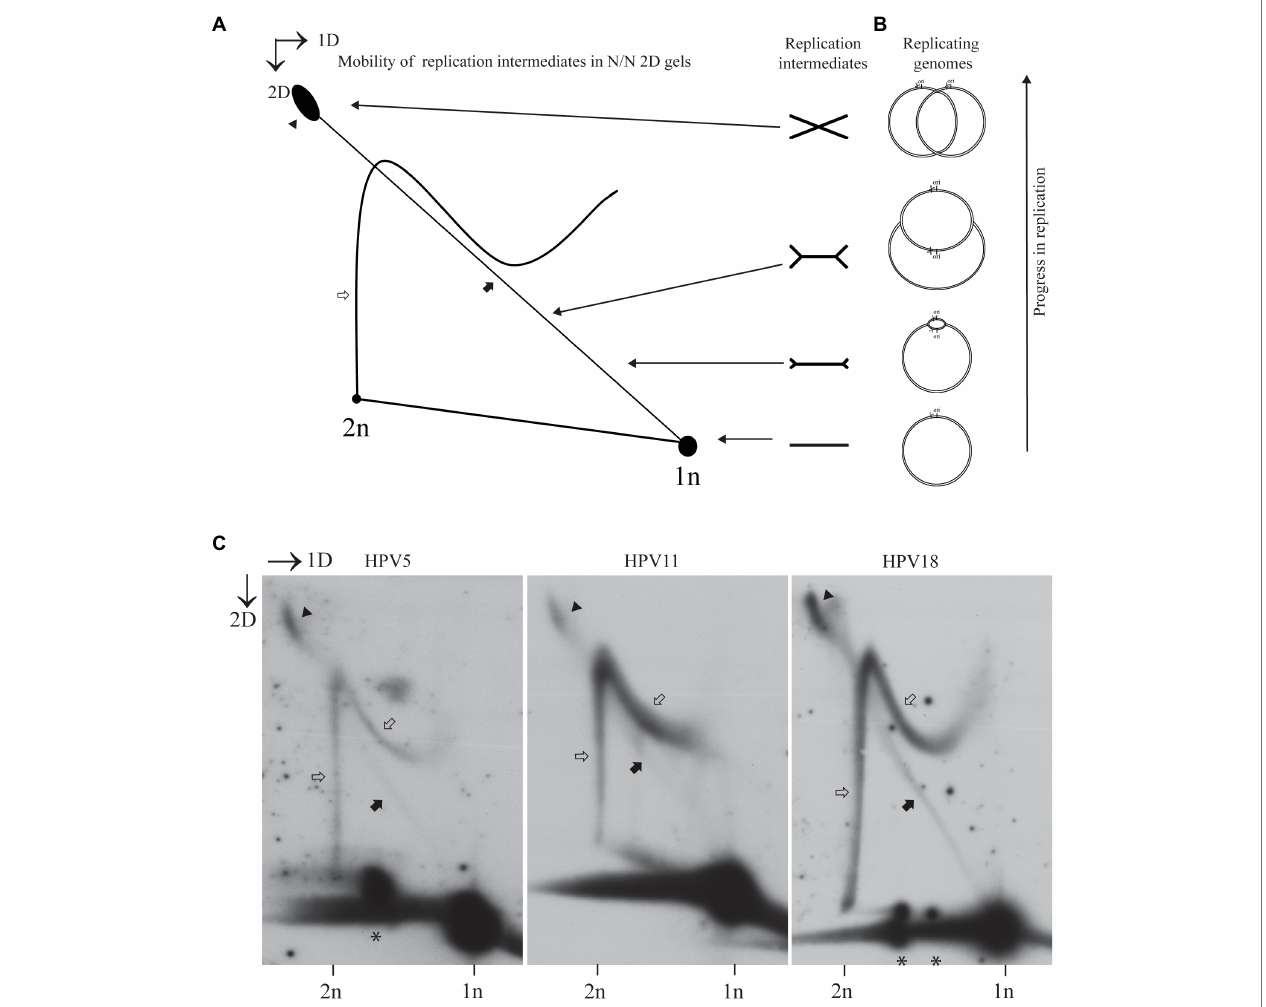
FIGURE 1 | Usage of the non-theta replication mechanism during transient replication is characteristic to different human papillomavirus (HPV) types. (A) Schematic representation of the expected mobility of the theta replication intermediates in neutral-neutral two-dimensional (2D) gel in case a circular replicon is linearized near the origin of replication (ori). Almost a straight diagonal line emanating from the spot of 1n linear molecules represents a doubleY structure, with two replication forks that started from the ori to opposite directions advancing as the line retreats from the spot of 1n linear molecules. A non-linear line ending in the 2D spot represents the structure arising from the non-theta type of replication. (B) Sketch of the HPV replicon at the different stages of bidirectional replication. Ori represents origin of replication; scissors refer to the position, where the HPV genome is linearized. (C) Neutral-neutral 2D analysis of the replication intermediates arising from the HPV5, HPV11, and HPV18 genome replication after transient transfection of the respective genomes into U2OS cells. Episomal DNA was extracted 72 h post-transfection, linearized with a restriction enzyme cutting near ori [HPV5 – SacI (nt 702); HPV11- BstEII (nt 7,899) HPV18 – BglI (nt 7,656)] run on an agarose gel at two dimensions and analyzed by Southern blotting (SB). Black arrows refer to the theta replication intermediates, black arrowheads refer to the almost fully replicated genomes, white arrows refer to the non-theta replication intermediates, asterisks depict the linear HPV genome fragments running between the size of 1n and